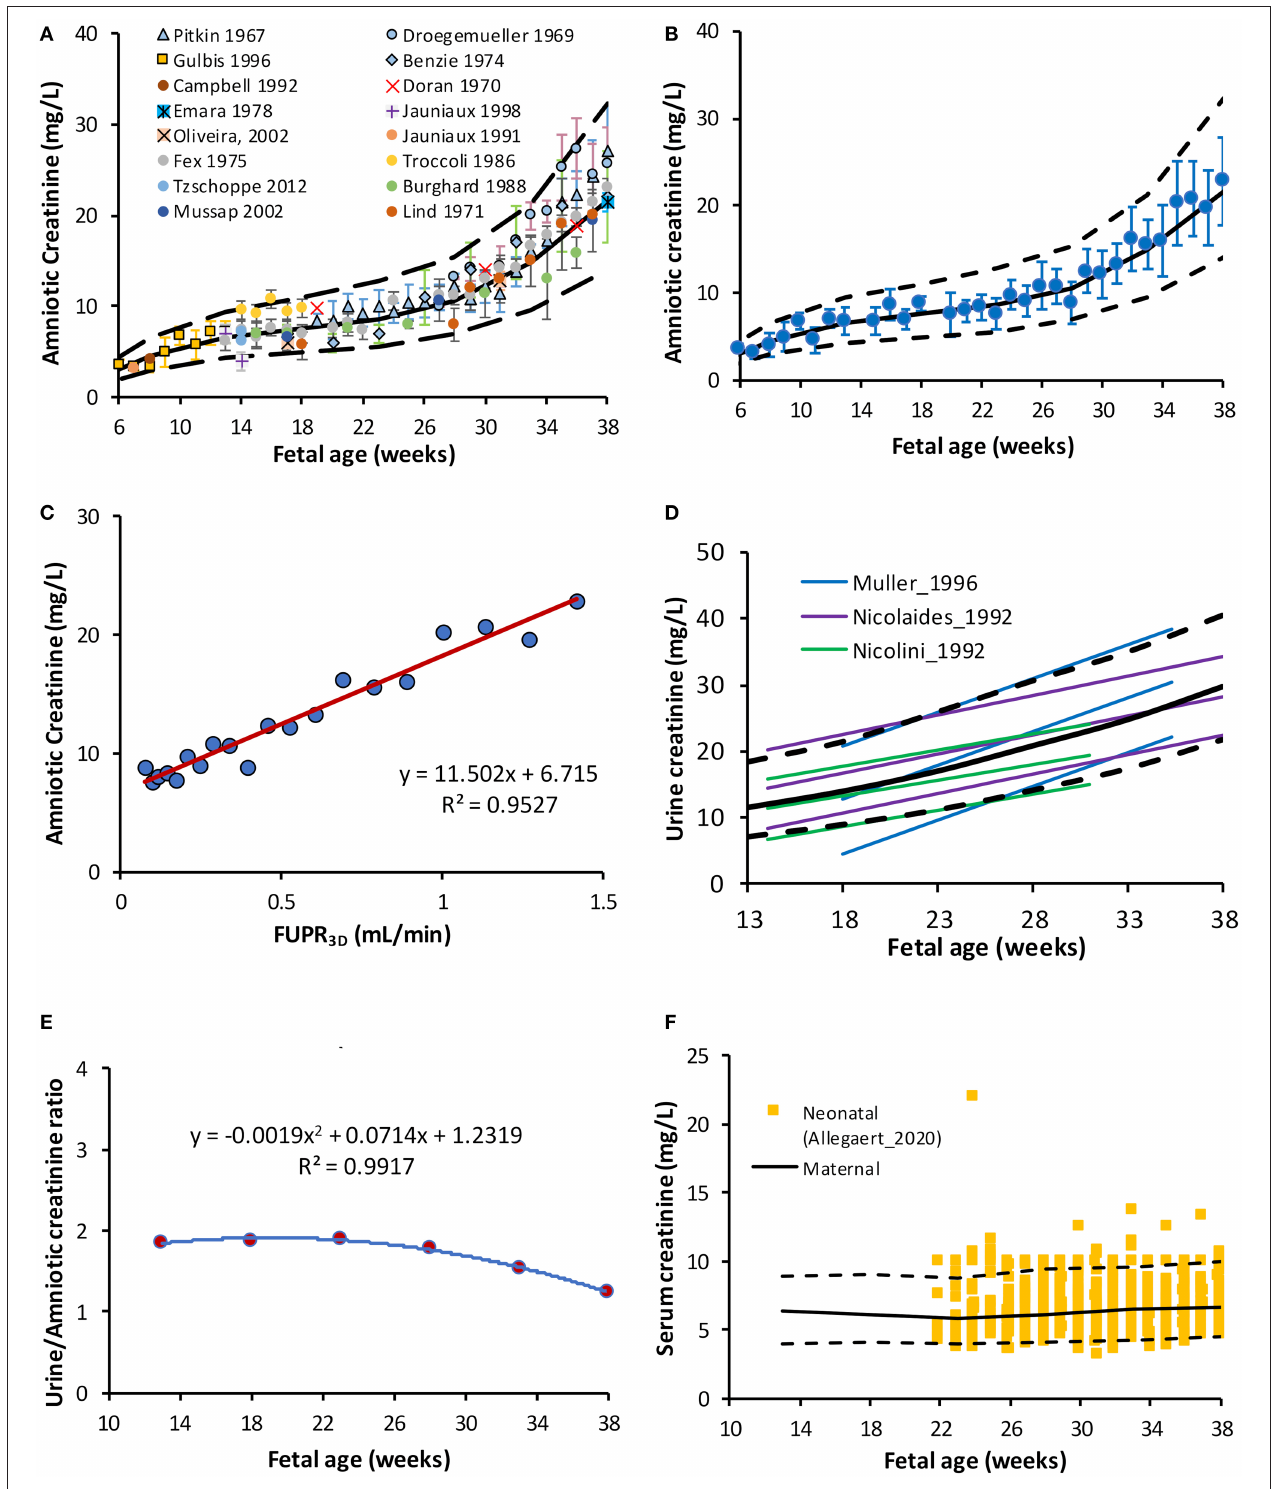
FIGURE 3 | Creatinine level in the amniotic and fetal fluids. (A) Fetal amniotic creatinine concentration as a function of fetal age, (B) weighted means (circles) and SD of amniotic creatinine level plotted against Fetal age, (C) Amniotic creatinine concentration against predicted FUPR based on the function derived from 3D data (D) reported references values for the creatinine in fetal urine from fetuses diagnosed with (6, 48) and without (49) urinary tract uropathies (E) Fetal amniotic to urine creatinine ratio, and (F) Serum creatinine in maternal serum [lines (50)] overlaying measured neonatal serum creatinine at birth [squares (51)]. Solid and broken lines represent the median and 5th-95th